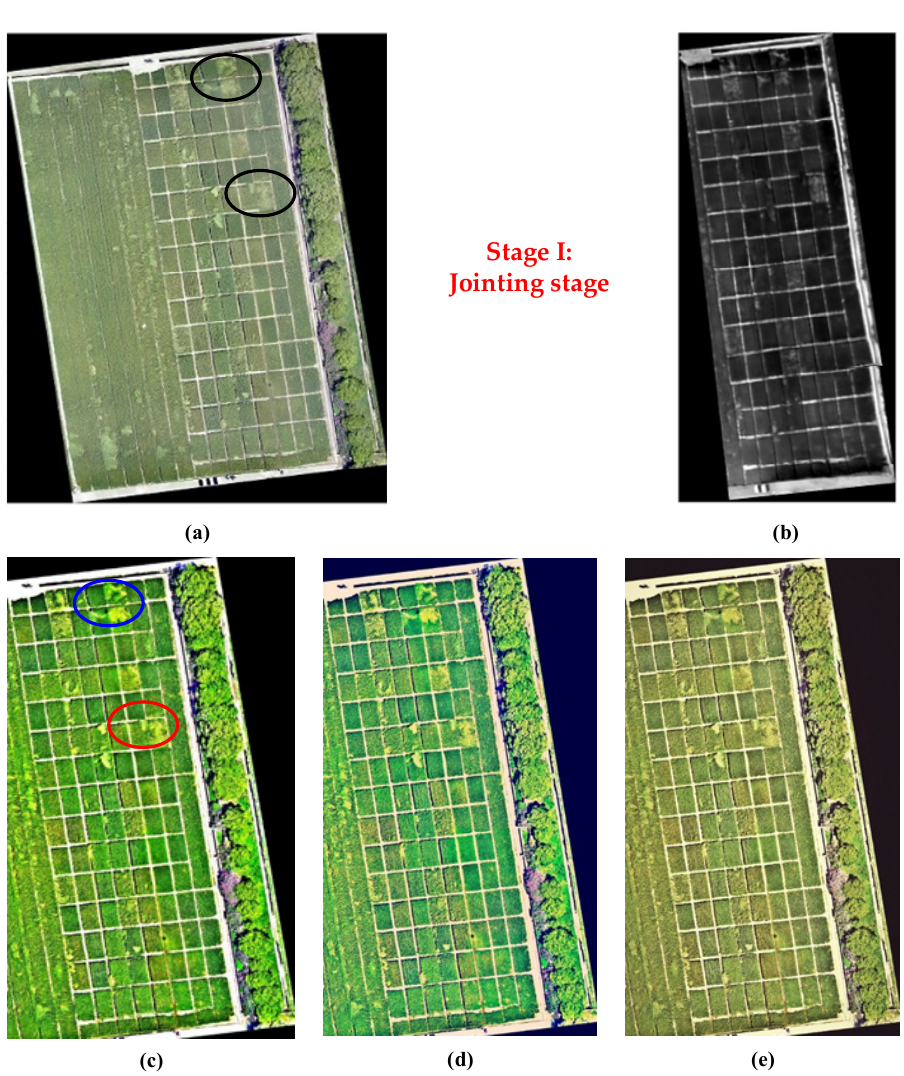
Figure 3. Comparison of fused images using our proposed method, reginal variance and IHS transform for Stage I. ( a ) Original visible image; ( b ) Original TIR image; ( c ) IHS-RVM; ( d ) Regional variance; and ( e ) IHS transform.